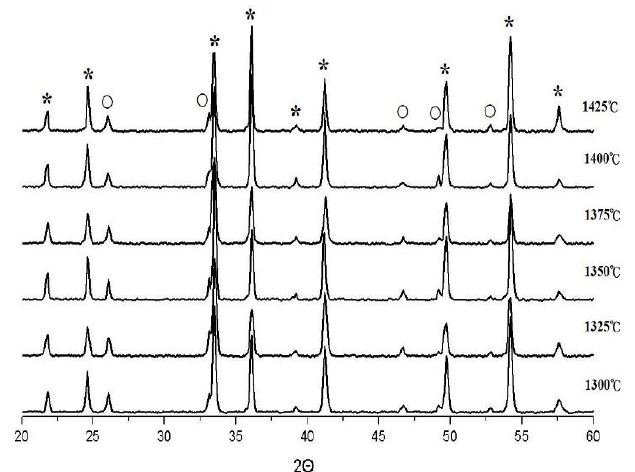
Figure 1. XRD analysis of MNT ceramics sintered at varied temperature holding times of 4 h. (*: MNT, ○ : MNT2).